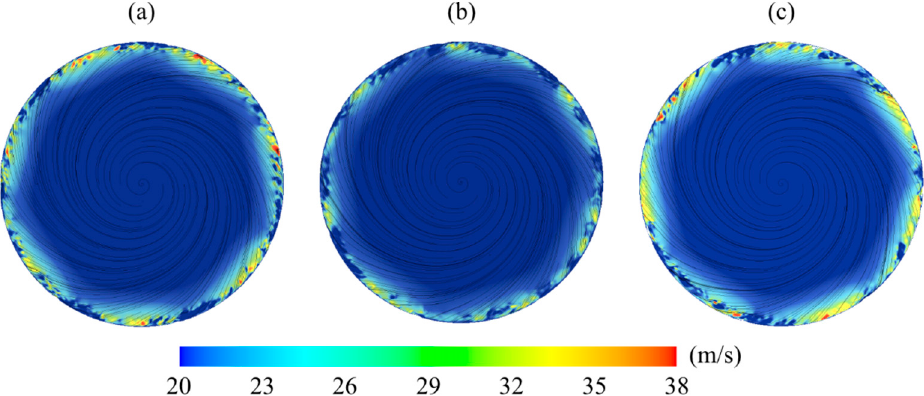
Figure 9. Instantaneous velocity magnitudes |𝑣 (cid:3019) | visualized in Plane 1: ( a ) Case 1, ( b ) Case 2, and ( c ) Case 3 . ( c ) Case